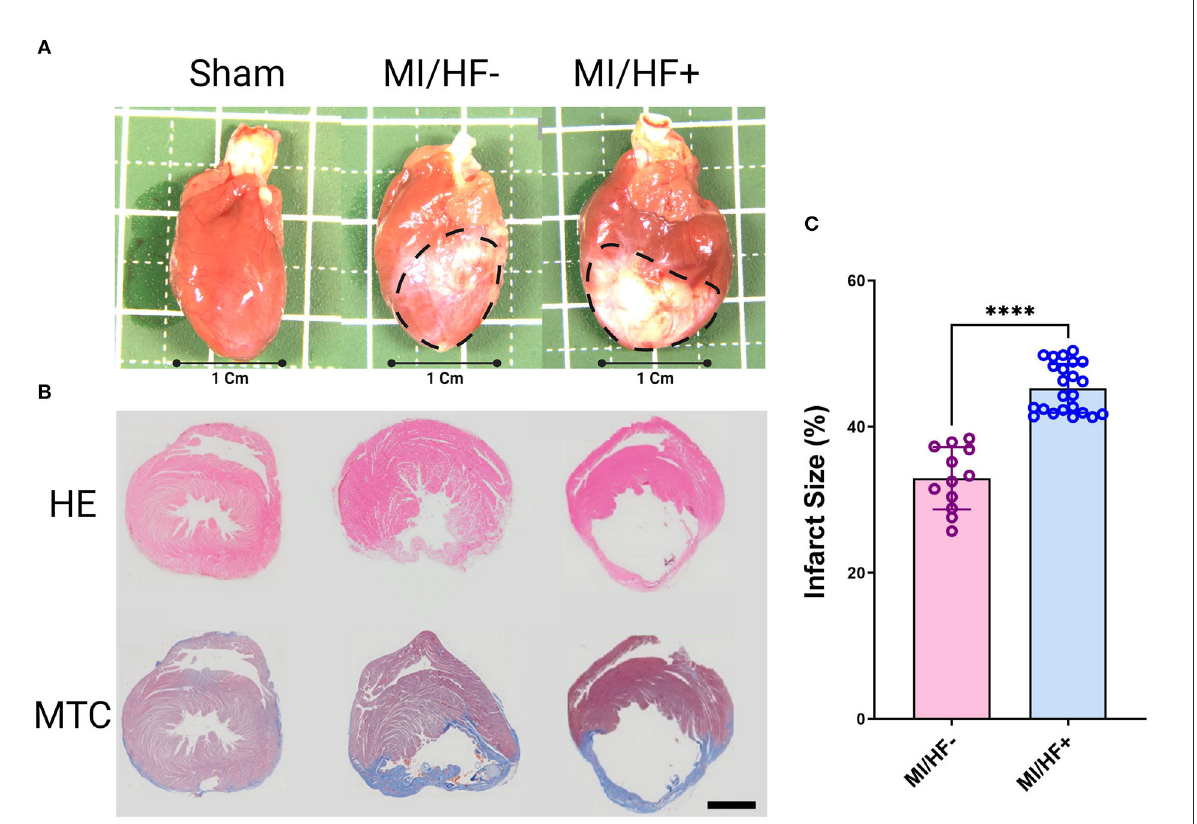
FIGURE5 Representative gross photographs (A) , Hematoxylin and Eosin (HE), and Masson’s trichrome (MTC) stained images of hearts (B) 6 months post-surgery. Quantitative assessment of the infarct size % in MI/HF– and MI/HF + groups (C) . The Black dotted area indicated an infarction